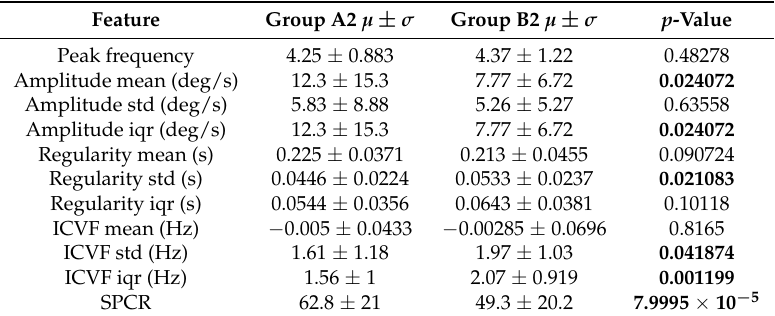
Table 4. Mean and standard deviation of different features for patients in A2 and B2 groups (ICVF—Inter-cycle variation of frequency; SPCR—Signal power concentration ratio; mean—average value; std—standard deviation; iqr—interquartile range). Statistically significant p -values ( p < 0.05) are highlighted with bold font.